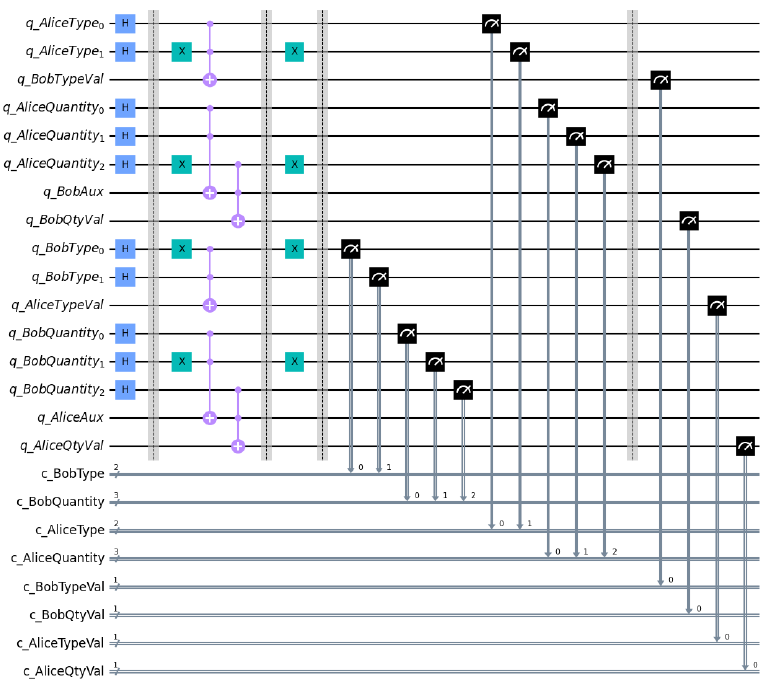
Figure 5. The quantum circuit that reflects the exchange between Alice and Bob. If Alice’s qubits are in the |1⟩ state (after the Hadamard and first layer of NOT gates), then the validation qubits of Bob will be set to |1⟩ , and vice versa.